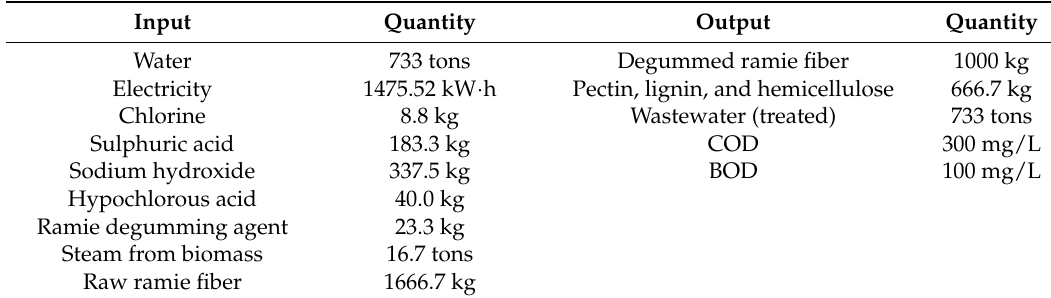
Table 3. Inputs and outputs of producing 1000 kg of degummed ramie fiber. COD—chemical oxygen demand; BOD—biochemical oxygen demand.